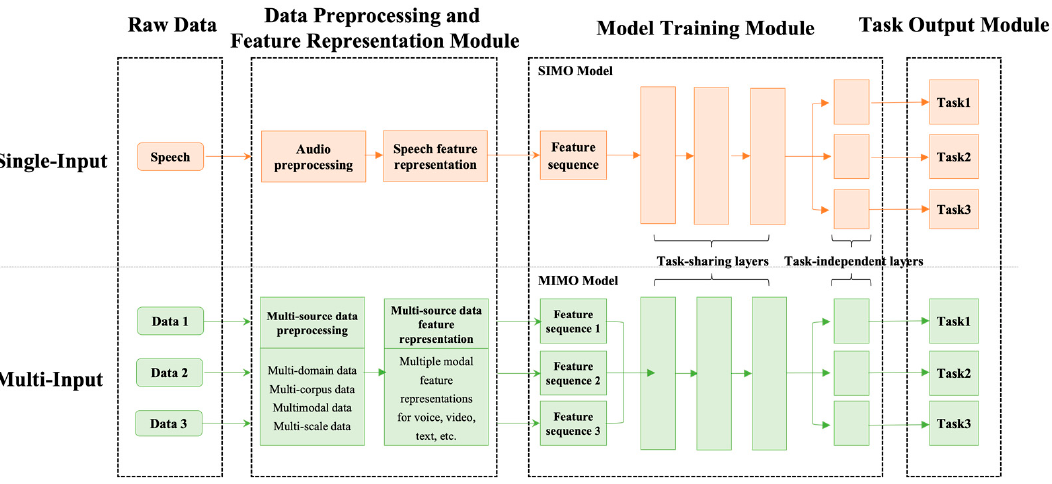
Figure 1. The framework of multi-task SER based on SIMO and MIMO.